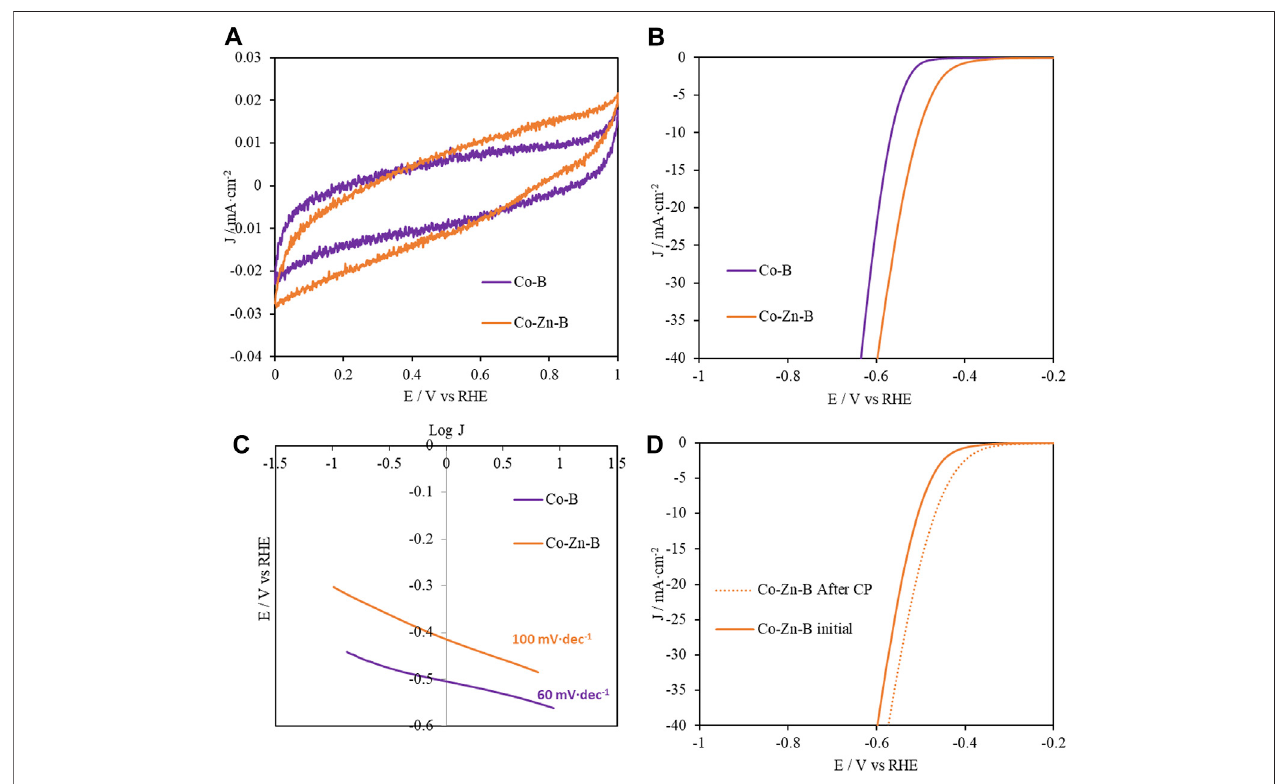
FIGURE 4 | (A) CV comparison of Co-B and Co-Zn-B samples at 50 mV s − 1 in a N 2 -saturated 1.0 M KOH solution. (B) LSV curves and (C) Tafel slopes of Co-B and Co-Zn-B for HER in 1.0 M KOH. (D) LSV curves of Co-Zn-B sample at 50 mV s − 1 in a N 2 -saturated 1.0 M KOH solution before and after chronopotentiometric